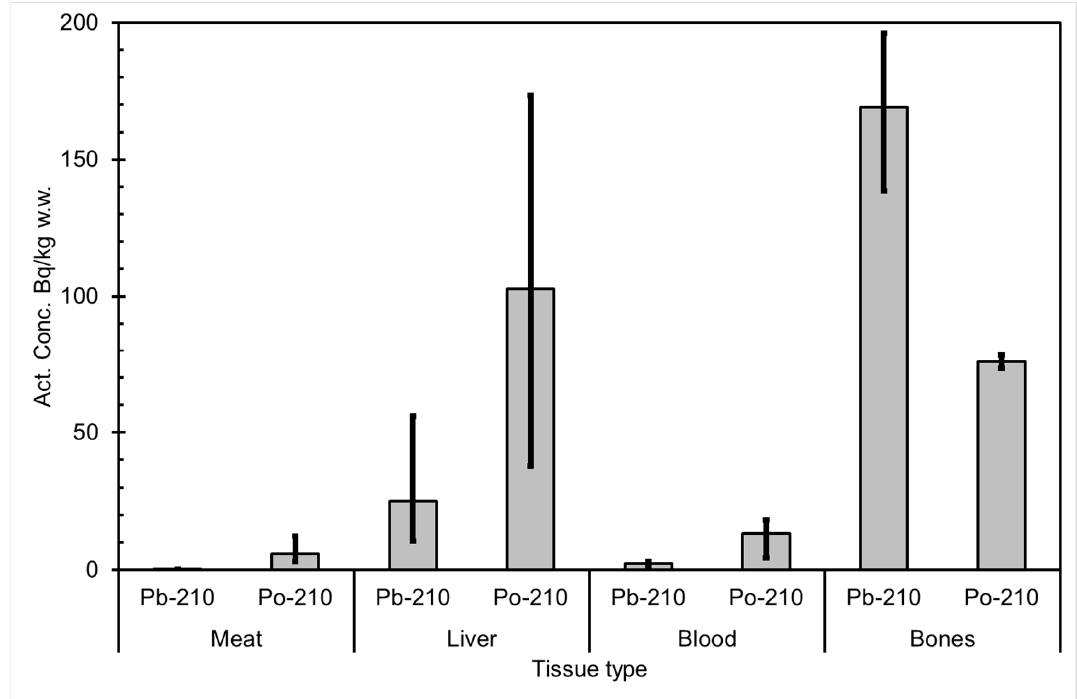
Figure 4. Average 210 Pb and 210 Po activity concentrations (Bq/kg wet weight) in reindeer tissues, compiled from data in [15]. The black vertical lines indicate the range of individual values.